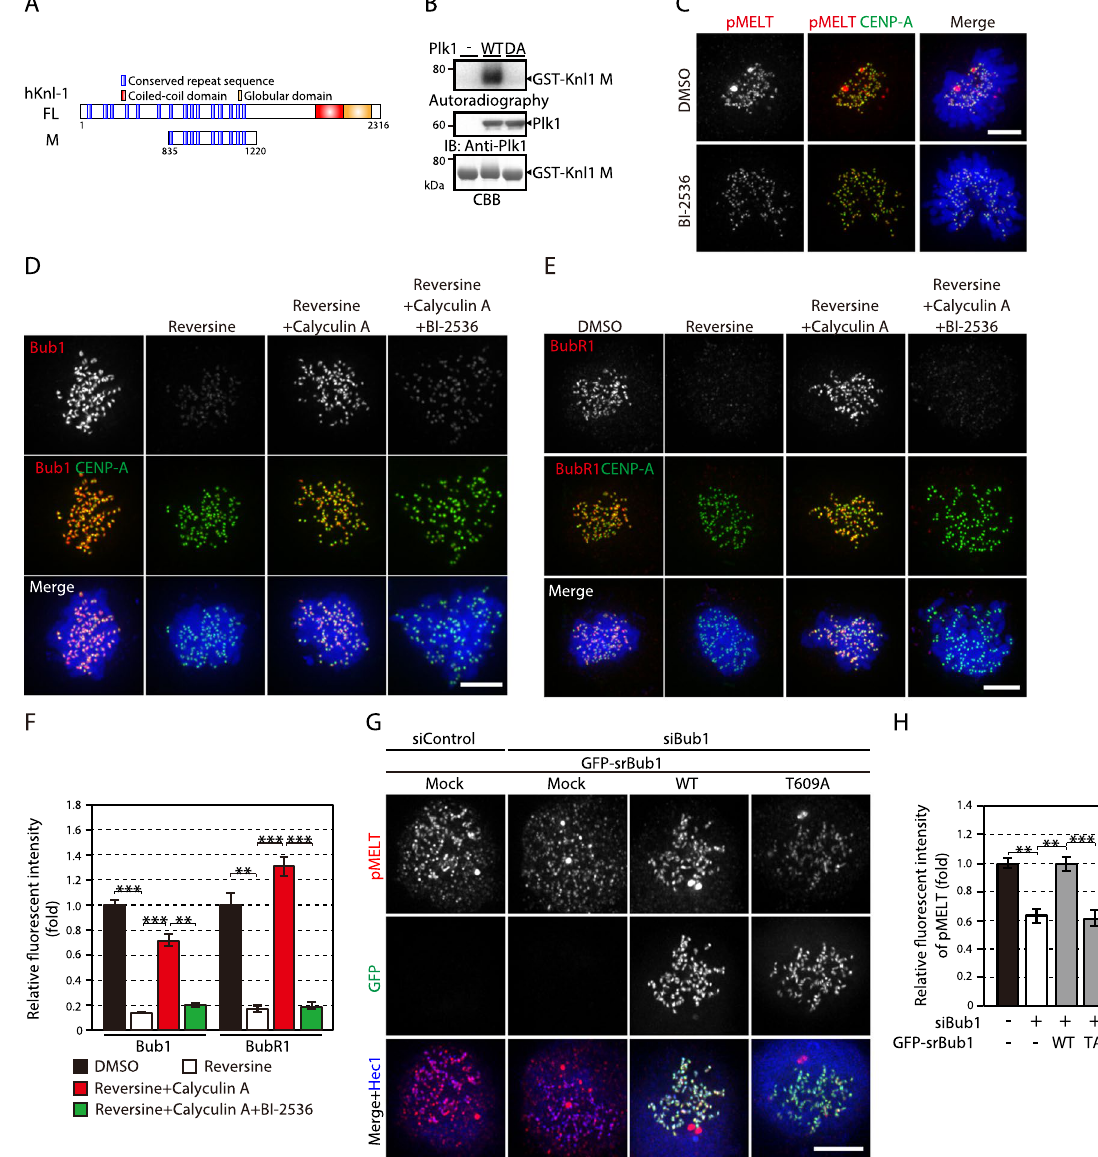
Figure 4. Plk1 recruited to kinetochores by Bub1 promotes Knl1 phosphorylation. ( A ) A Knl1 fragment containing the MELT repeats (hKnl1 M) is schematically shown. ( B ) Phosphorylation of the MELT repeats by Plk1. A Knl1 fragment shown in ( A ) purified from insect cells was subjected to an in vitro kinase assay in the presence of wild-type (WT) or kinase-dead (DA) Plk1. γ - 32 P-ATP incorporated into the Knl1 fragment was detected by autoradiography, and Plk1 was detected by western blotting. ( C ) Knl1 phosphorylation at the MELT repeats in cells treated with BI- 2536. Cells expressing CENP-A-GFP (green) in early PM were treated with or without 300 nM BI-2536 and stained with an antibody against a phosphorylated MELT repeat (pMELT; red). DNA was stained with DAPI (blue). Scale bar: 5 μ m. ( D ) Kinetochore localization of Bub1 in nocodazole-treated HeLa cells in the presence of 500 nM reversine with or without calyculin A and BI-2536. Cells expressing CENP-A-GFP (green) were immunostained with an antibody against Bub1 (red). DNA was stained with DAPI (blue). Scale bar: 5 μ m. ( E ) Kinetochore localization of BubR1 in cells treated as in ( D ). Cells expressing CENP-A-GFP (green) were immunostained with an antibody against BubR1 (red). DNA was stained with DAPI (blue). Scale bar: 5 μ m. ( F ) Quantification of Bub1 and BubR1 on kinetochores. The fluorescence intensity of Bub1 and BubR1 in cells treated as in ( D ) and ( E ) is shown. The signal intensity in DMSO-treated cells was set as 1. The intensity of Bub1 or BubR1 obtained from a single experiment, representing three independent experiments, was measured for at least 95 kinetochores per cell (5 cells) per condition. Error bars represent S.E. ** P < 0.001; *** P < 0.0005 (two-tailed t -test). ( G ) Knl1 phosphorylation at the MELT repeats in Bub1-depleted cells. Cells were treated as in Fig. 3B and stained with an antibody against a phosphorylated MELT repeat (pMELT; red), GFP (green), or Hec1 (blue). Scale bar: 5 μ m. ( H ) Quantification of Knl1-pMELT signal on kinetochores. The fluorescence intensity of Knl1-pMELT in cells treated as in ( G ) was measured for at least 42 kinetochores per cell (5 cells) per condition. Data was obtained from a single experiment, representing three independent experiments. Error bars represent S.E. ** P < 0.005; *** P < 0.0005 (two-tailed t